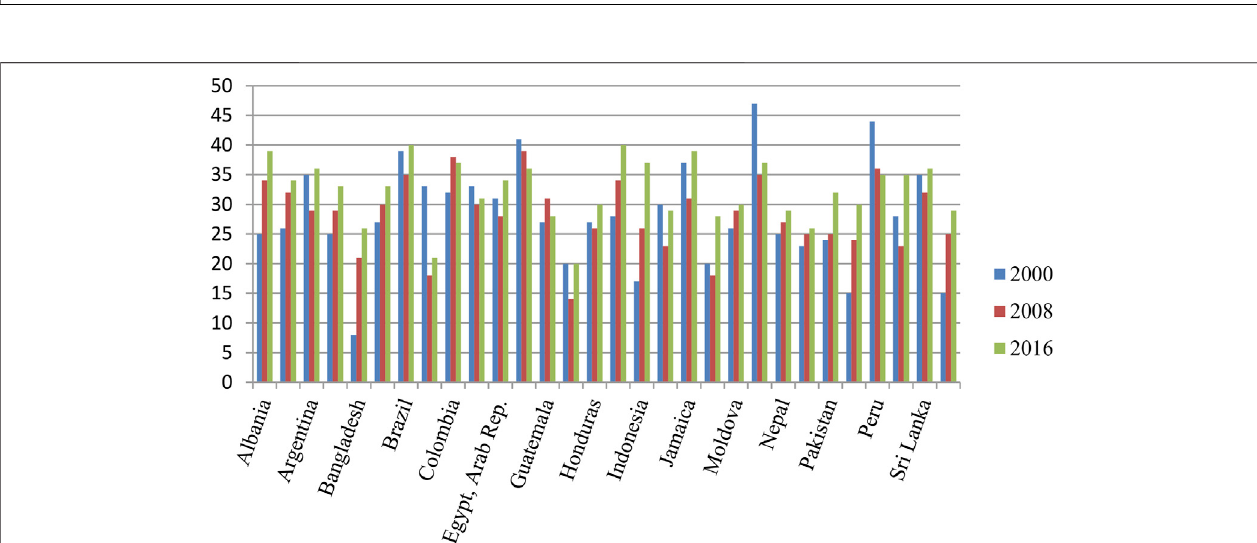
FIGURE 3 | GDP growth (annual %) in sub-Saharan Africa. Source: World Development Indicator (2016).